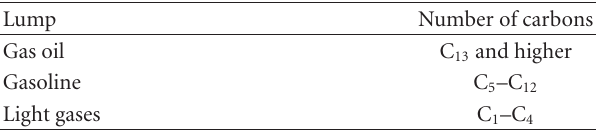
Table 2: Definition of lumps [27].